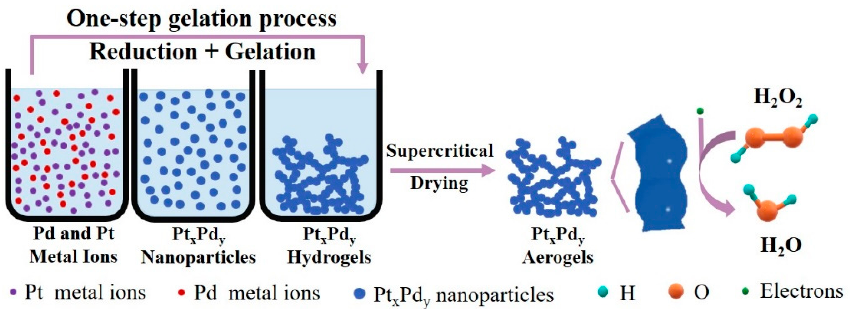
Scheme 1. Schematic illustration of the synthesis of Pt x Pd y aerogels for electrochemical sensing of H 2 O 2 .